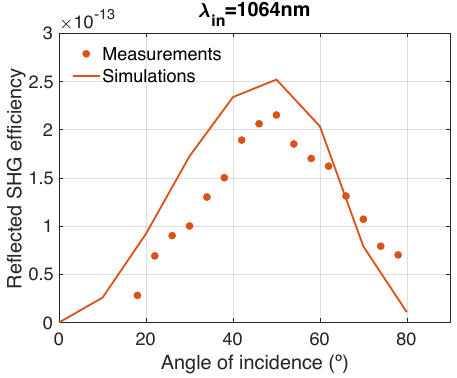
Fig. 1. Measured (full circles) and predicted (solid curve) reflected SHG efficiencies as a function of incident angle from a 25nm-thick amorphous silicon layer when the pump pulse is tuned at 1064nm and both fundamental and SH fields are TM- polarized.